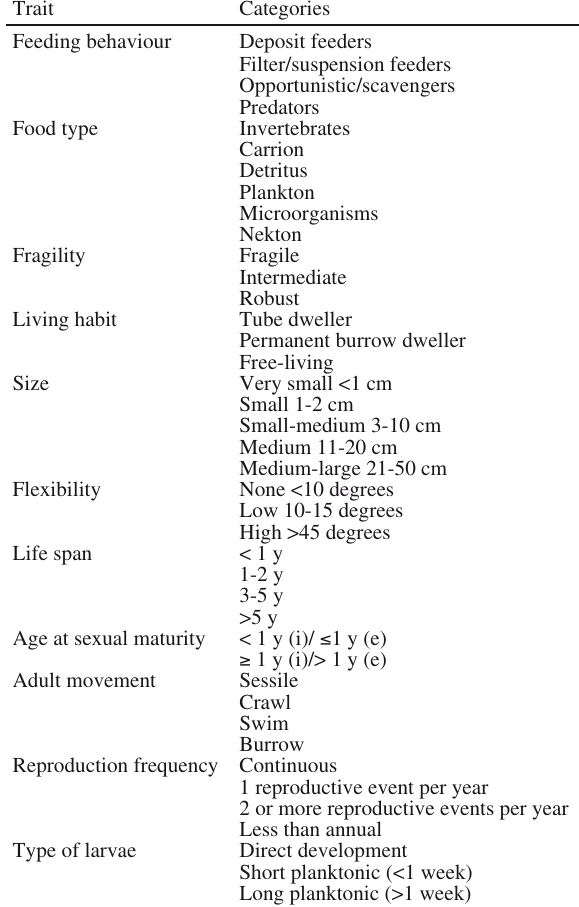
Table 2. – Biological traits and categories used to describe func- tional components of benthic communities. Categories used in (i) infaunal and (e) epifaunal